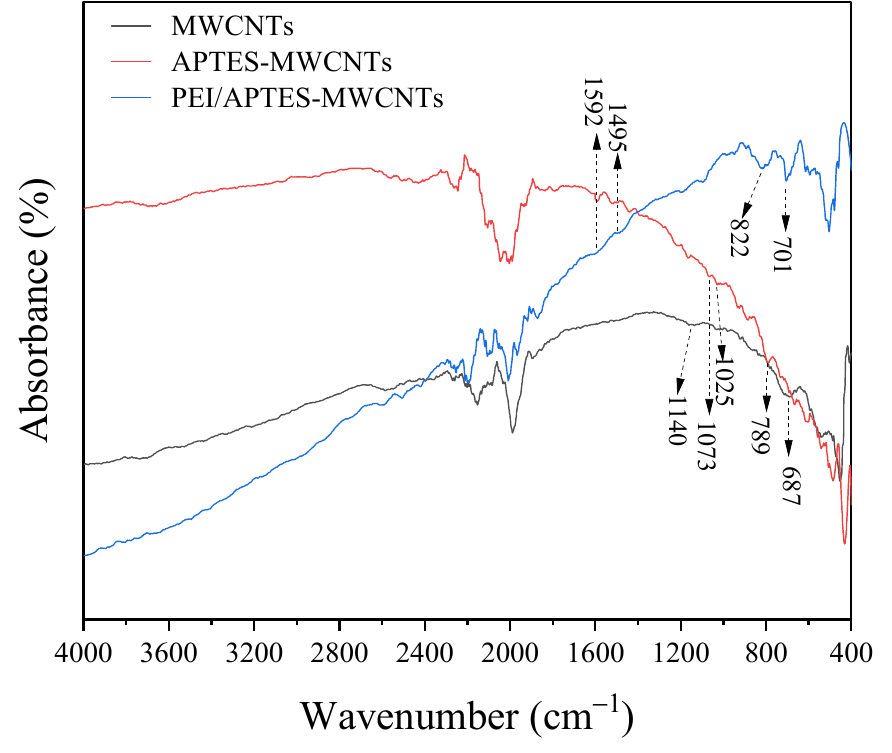
groups of PEI, indicating that PEI was successfully crosslinked to the surface of APTES- MWCNTs. Figure 3. FTIR spectra of MWCNTs, APTES-MWCNTs, and PEI/APTES-MWCNTs. Table 1. Specific surface area, average pore size, and total pore volume of the materials. Sample